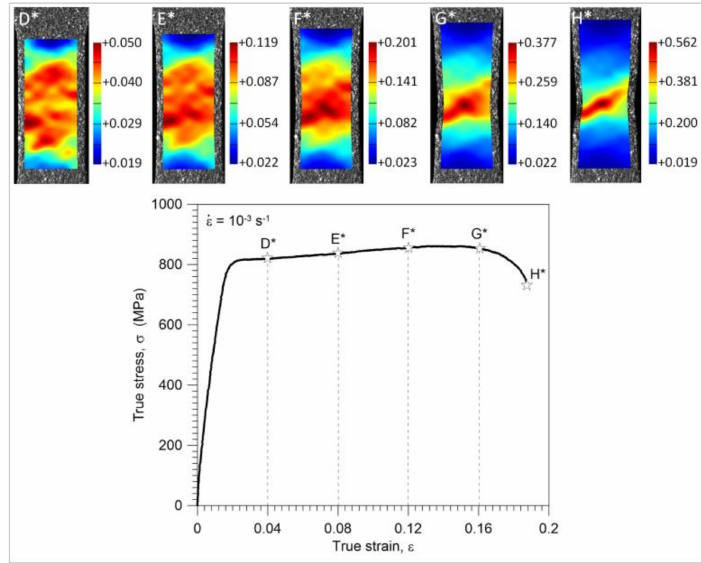
Figure 7. Stress versus strain completed by DIC distributions for Gum Metal during tension at a strain rate of 10 − 3 s − 1